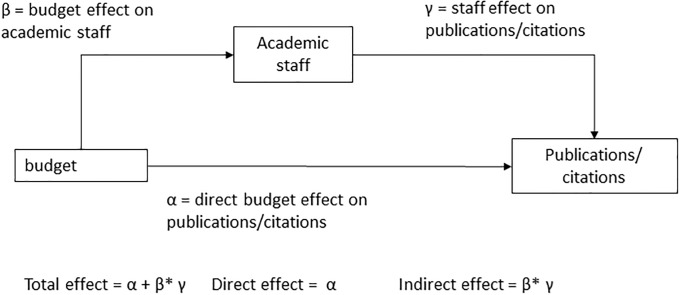
Mediation model.